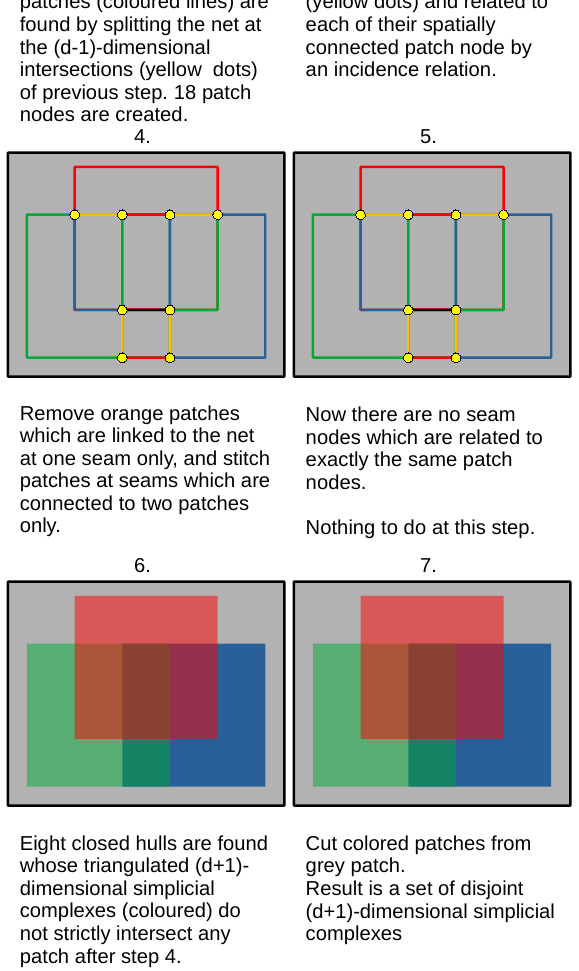
Figure 4. Five 1 -dimensional simplicial complexes triangulated to eight 2 -dimensional disjoint simplicial